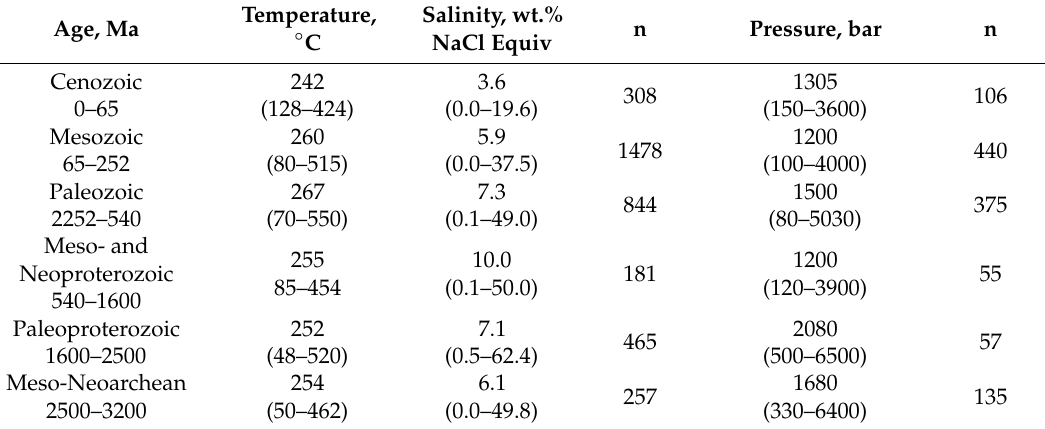
Table 8. Median values of main physicochemical parameters of mineral-forming fluids of orogenic gold deposits.